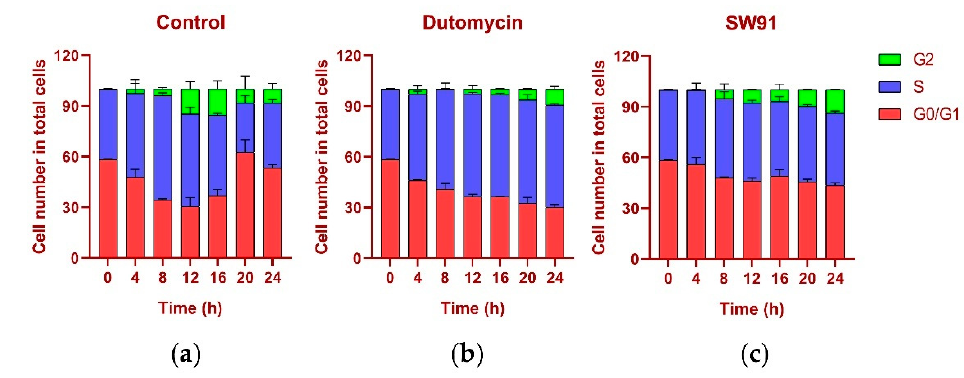
Figure 5. Cell cycle percentage stacking plots for different time periods 0-24 (h) to illustrate the cycles of cells treated with drugs at their IC 50 concentrations: ( a ) plot of cell cycle percentage stacking at different time periods 0–24 (h) after addition of dutomycin; ( b ) plot of cell cycle percentage stacking at different time periods 0–24 (h) after addition of SW91; ( c ) plot of cell cycle percentage stacking at different time periods 0–24 (h) after addition of control.